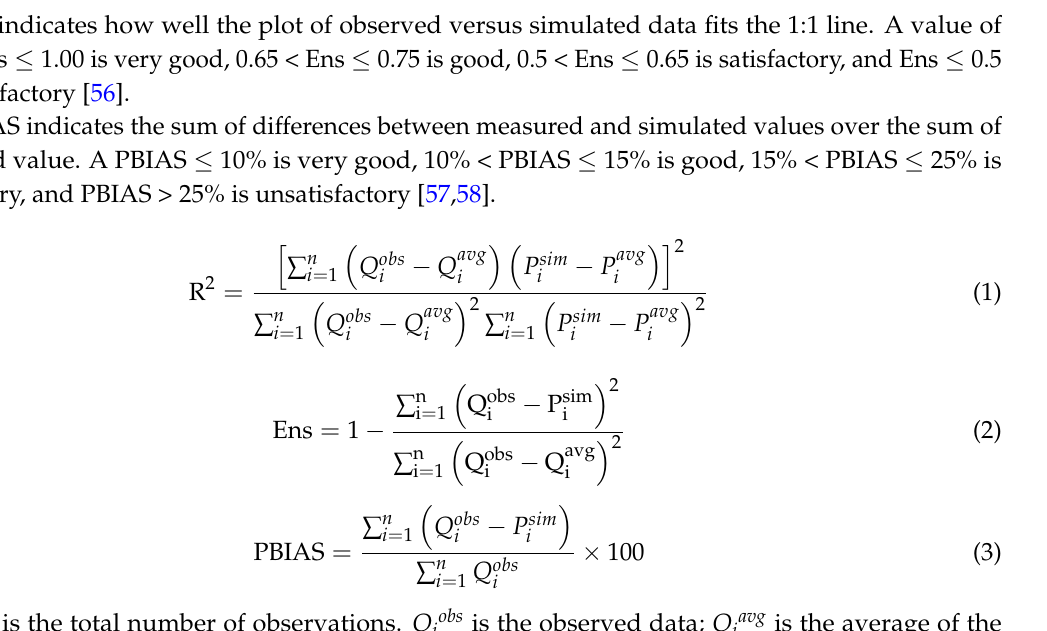
Figure 2. Map of the subbasins.